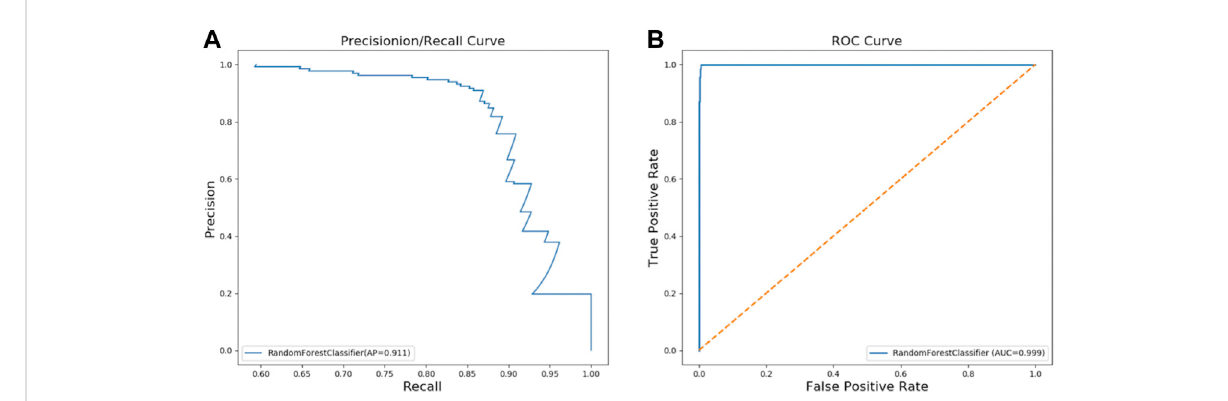
FIGURE 2 Two curves for PKU screening using RFC in the validation dataset: (A) PR curve; (B) ROC curve.